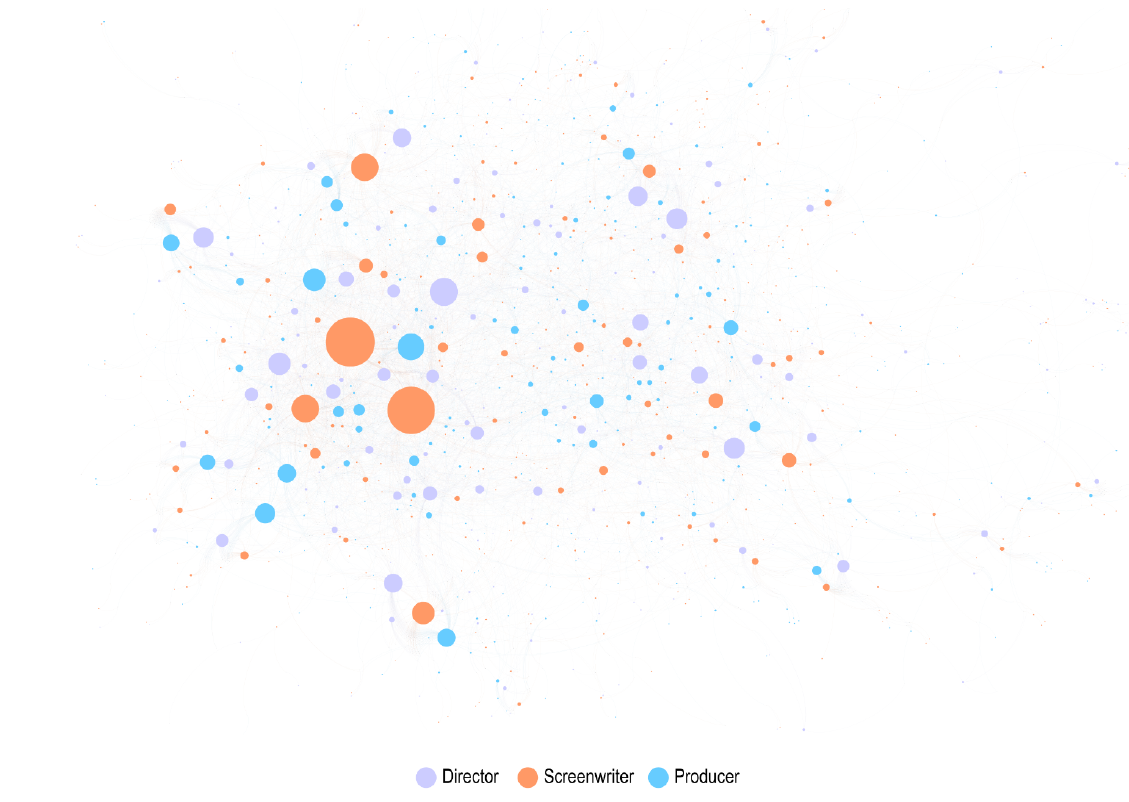
Figure 2 . Professions in the Yeşilçam film industry (1960-1979). Colored nodes represent the professions, while grays are the films, and edges indicate relations between professions and films. Node size is proportional to weighted